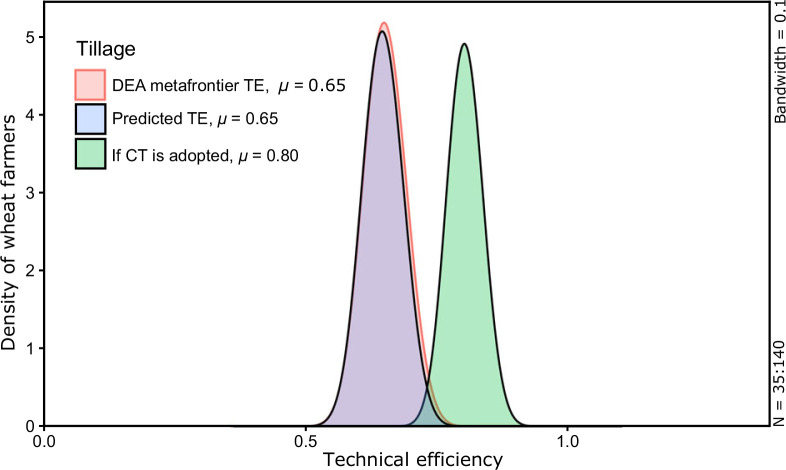
Counterfactual effect of farmers using traditional tillage (TT). The
density curves with red outer line and pink shaded area shows
estimated bias corrected meta-frontier TE from DEA, while the curve
with black outer line and blue shaded area shows the predicted TE
from endogenous switching regression. The curve with black outer
line and green shaded area presents the TE of TT farmers under a
hypothetical scenario if they would have adopted the CT practice
(color figure online)